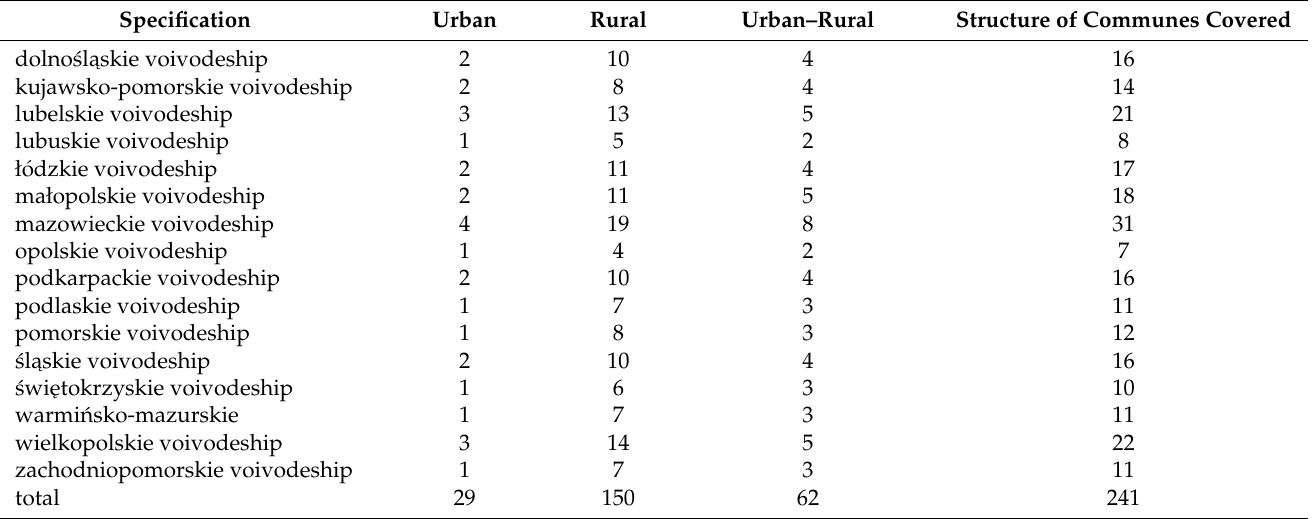
Table 3. Structure of the research